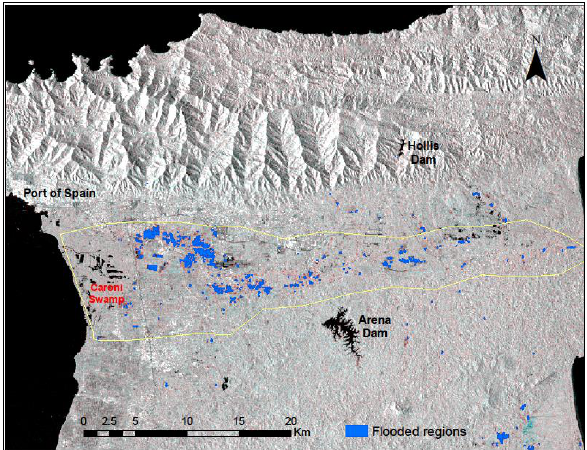
Figure 4. Flooded regions in northern Trinidad delineated in Sentinel-1 SAR